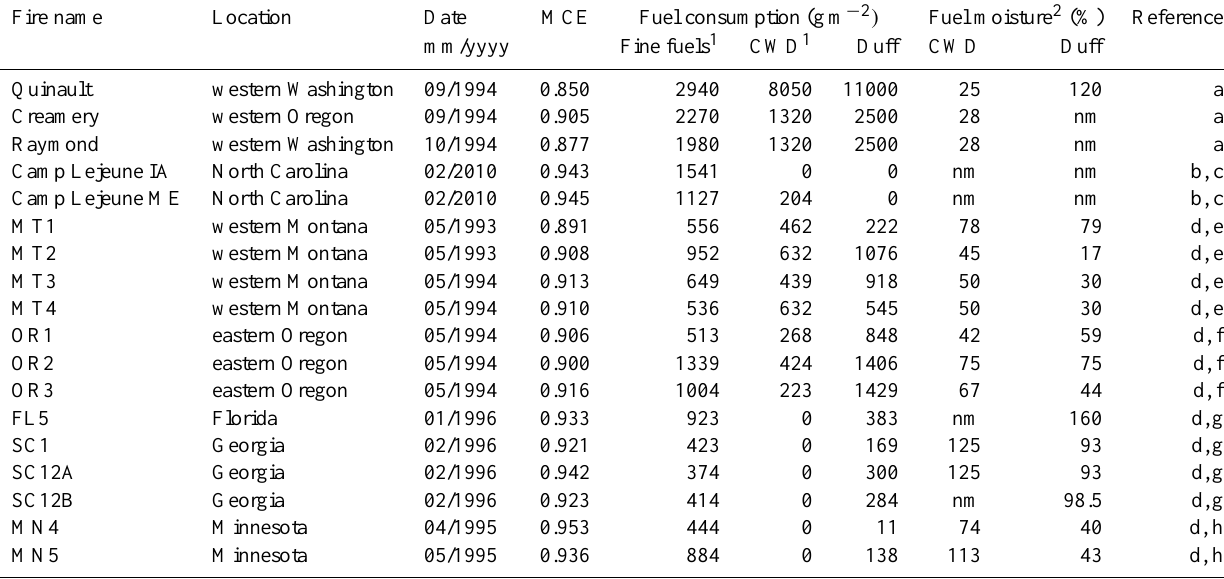
Table A1. Fire name, location, date, fuel consumption, fuel moisture, and MCE for 18 prescribed fires from previous